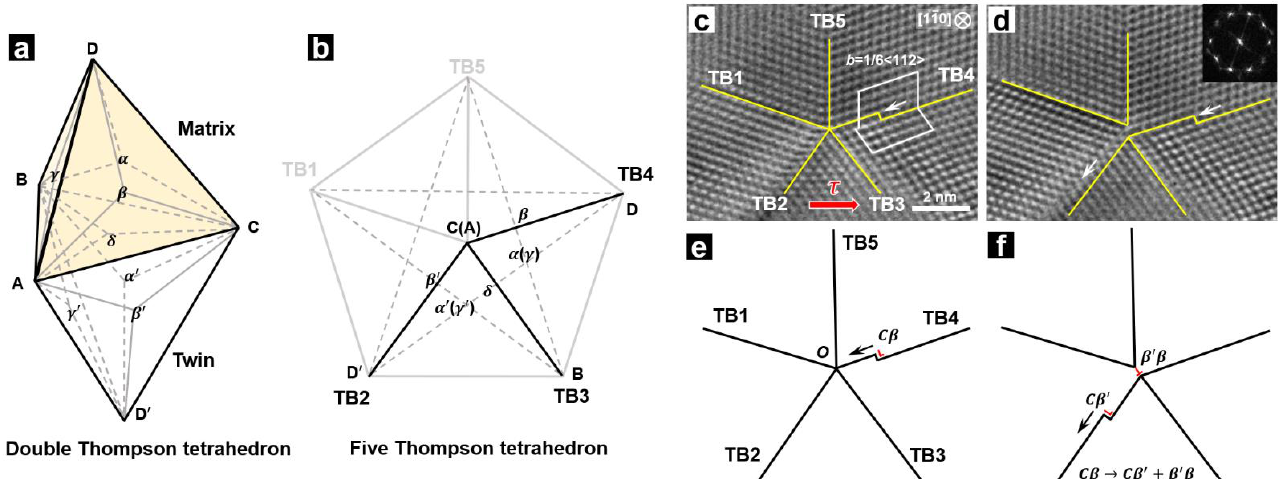
Figure 2. Dislocation-induced dissociation of the penta-twin core. ( a , b ) Double Thompson tetrahedron and its representation in five adjacent Thompson tetrahedrons used for dislocation analyses within penta-twins. ( c , d ) Twinning partials transmitting across the penta-twin core induces the dissociation of the penta-twin core, as well as migrations of TB2 and TB4 by one atomic layer. Frank circuit in ( c ) ascertains the dislocation content of a twinning partial/disconnection. The inset in ( d ) shows the corresponding fast Fourier transform (FFT) pattern of the penta-twin. ( e , f ) Schematic diagrams of the dislocation-induced dissociation of the penta-twin core.